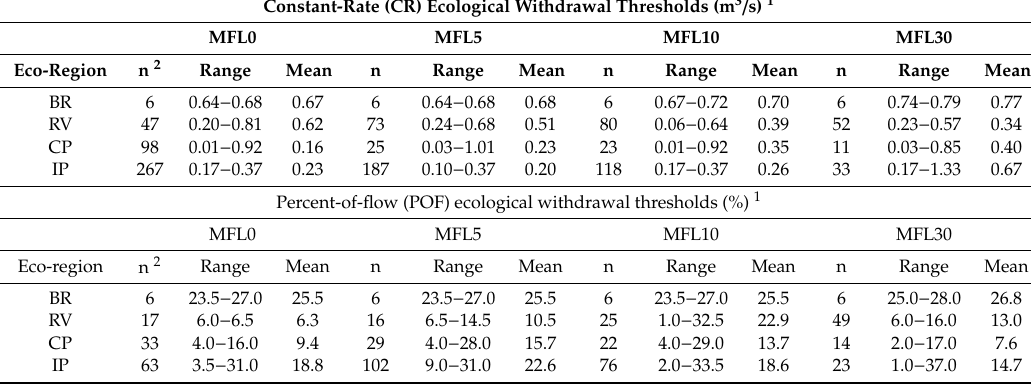
Figure 7. Boxplots of predicted ecological withdrawal thresholds under constant-rate withdrawal scenarios among select fish groups and minimum flow levels (MFLs) for Blue Ridge (BR), Ridge and Valley (RV), Cumberland Plateau (CP), and Interior Plateau (IP) ecoregions. Boxes represent the 25th and 75th quantile; center line represents the median (50th percentile). Points are threshold values for individual stream sites and are color coded by drainage-area size. Results for all fish groups are illustrated in Figure S17. Table 5. Range and mean of median values (across fish groups) of predicted ecological withdrawal thresholds under constant-rate (m 3 / s) and percent-of-flow (%) withdrawal scenarios for each ecoregion. “n” = cumulative number (sum) of sites that reached an ecological withdrawal threshold across all fish groups for each ecoregion.